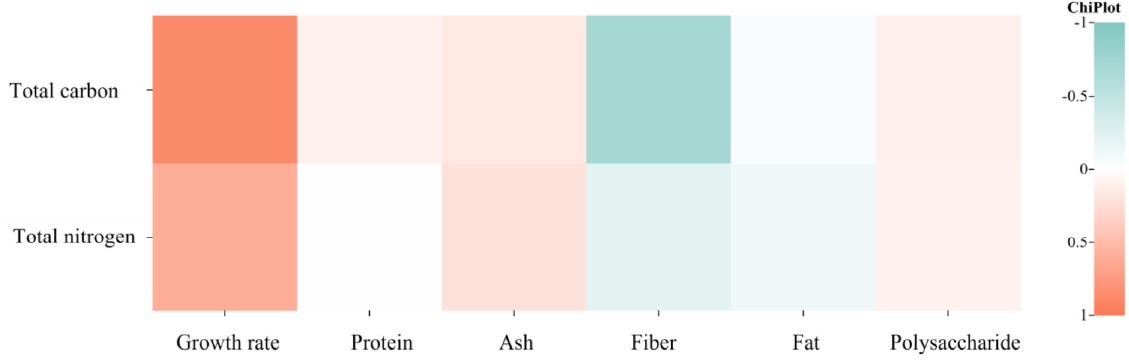
Figure 4. The heatmap depicts the relationship between the contents of C and N of the substrate on the nutritional quality of the substrate and the rate of mycelial growth.